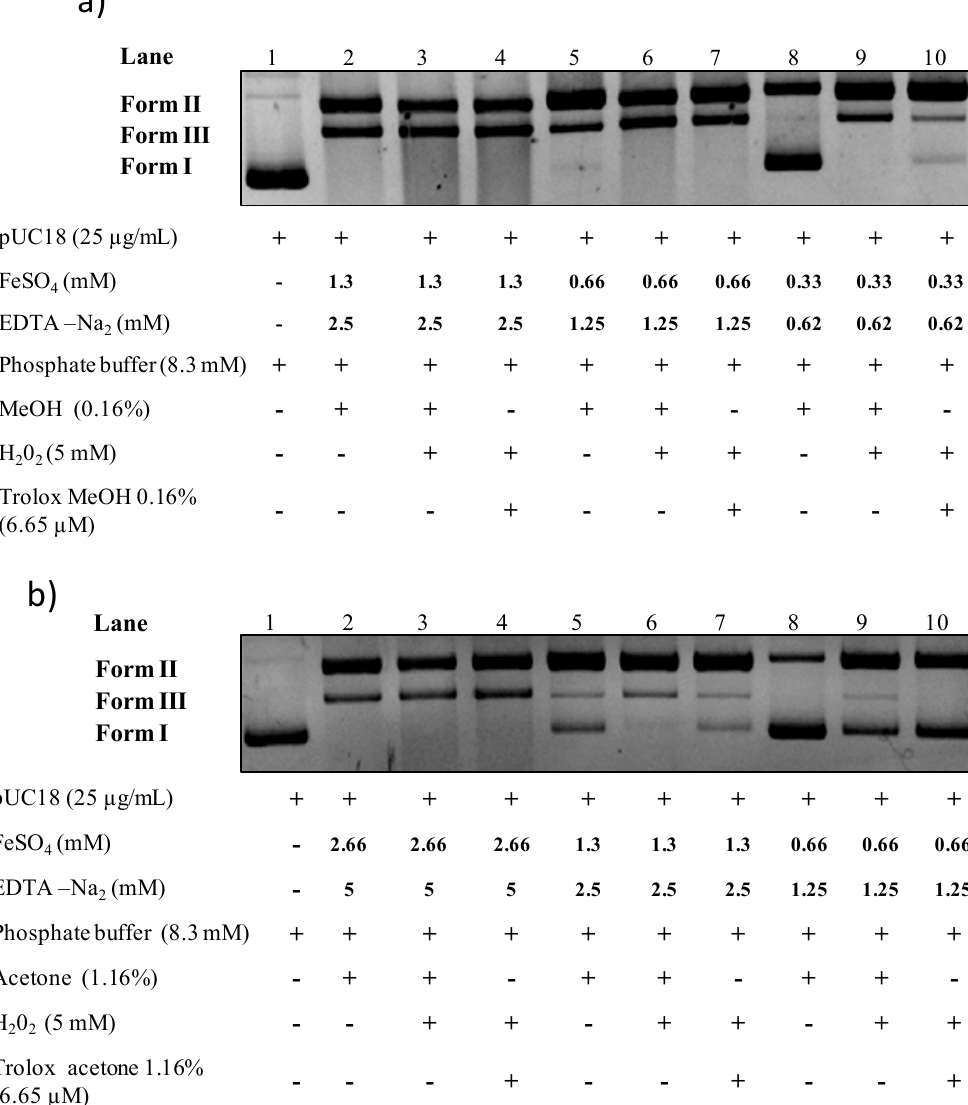
Figure 4. ( a ) Development of a pUC18 DNA nicking assay with methanolic solvent; (b ) Development of a pUC18 DNA nicking assay with acetonic solvent. Reaction mixtures were incubated for 15 min at 37 °C for acetone and for 1.5 h for methanol. Form I—supercoiled double stranded DNA; Form II—open circular DNA; Form III—nicked linear